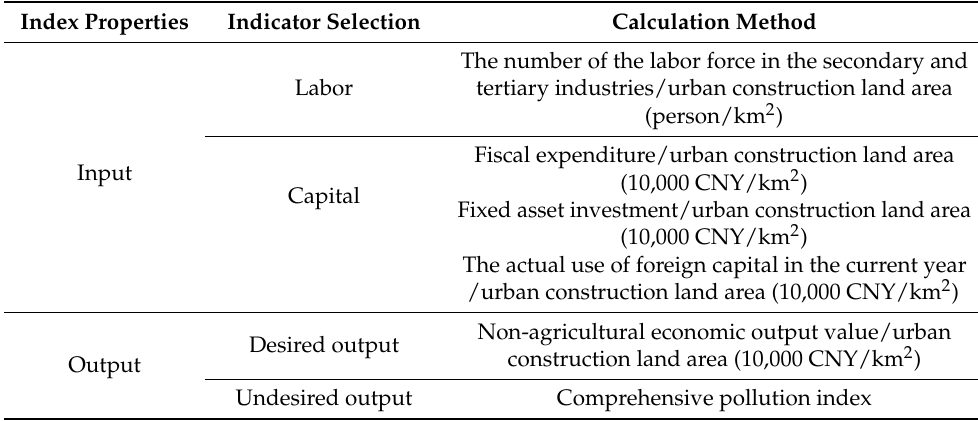
Table 1. Evaluation indicators of the production function.